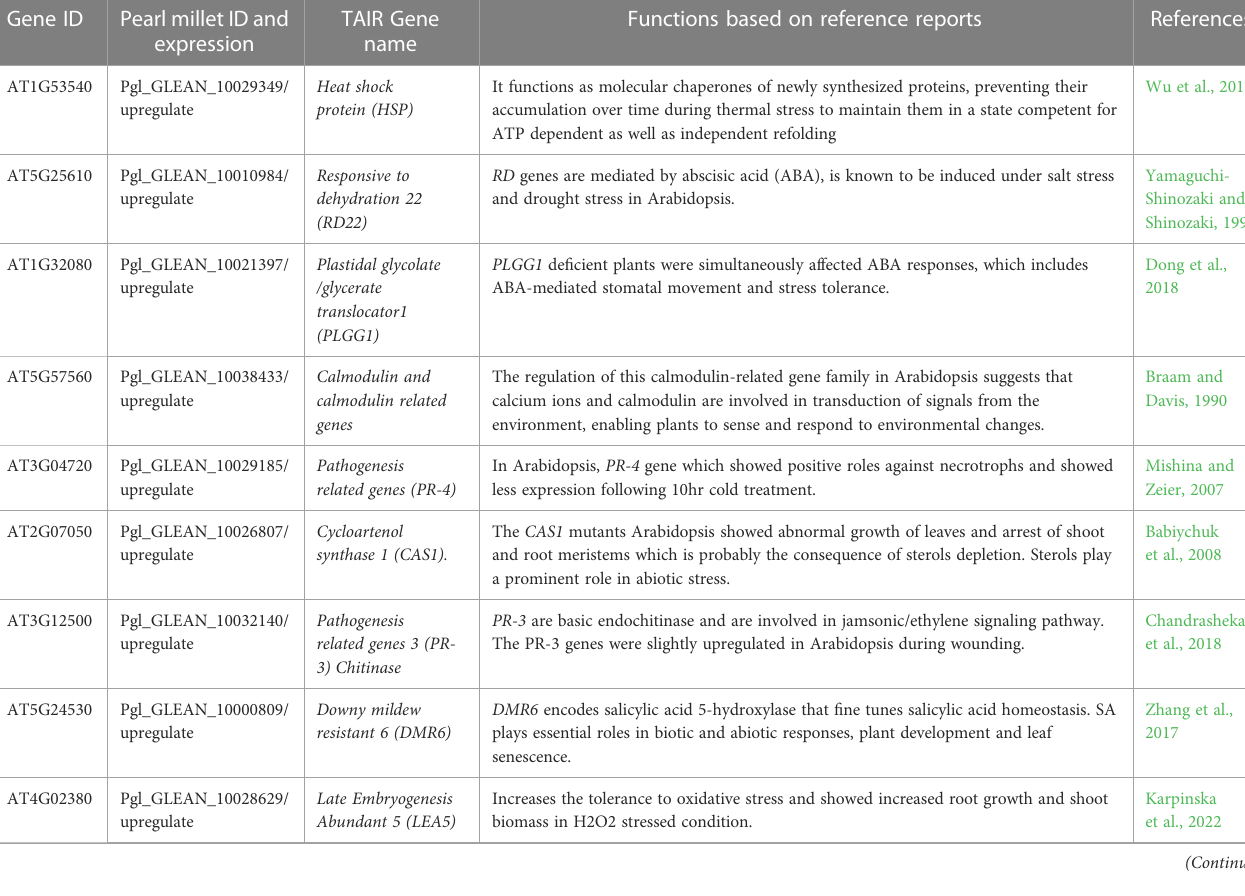
TABLE 3 Detailed functions of shared genes from transcriptomics data. The function of genes is from original papers not just from TAIR database. Gene ID